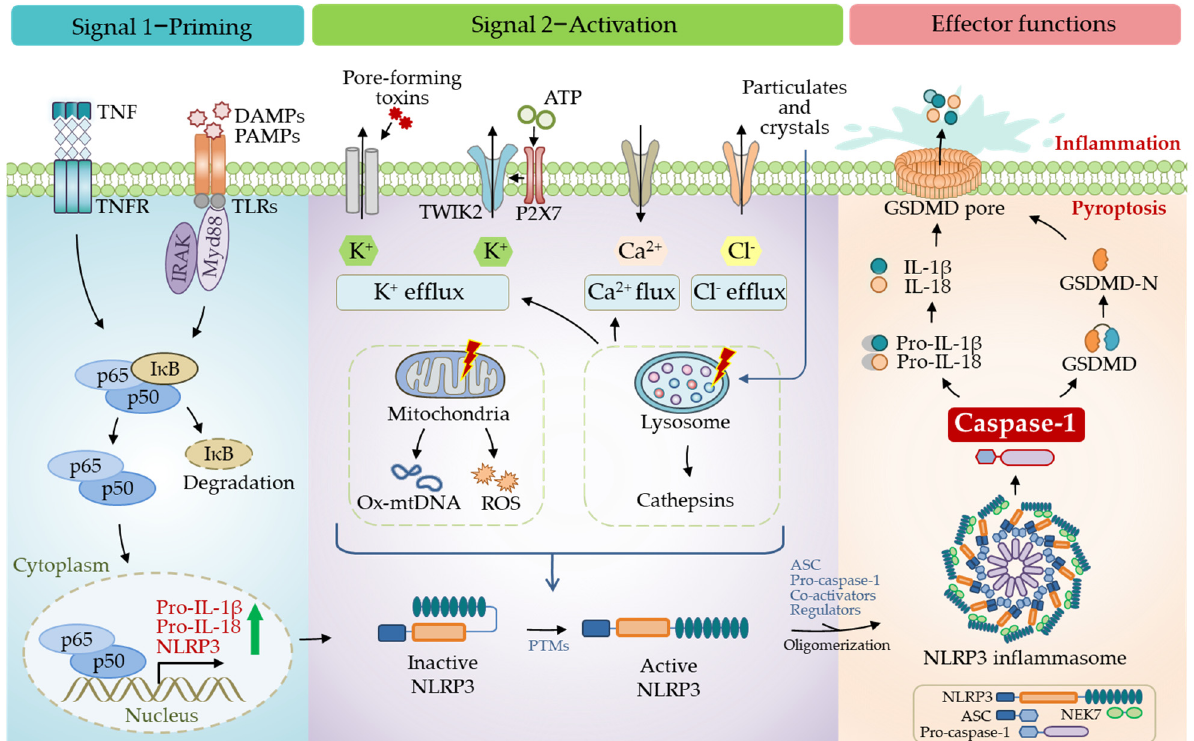
Figure 3. Activation of the NLRP3 inflammasome. Activation of the NLRP3 inflammasome undergoes two sequential steps. The priming process (signal 1) includes the recognition of PAMPs/DAMPs through TLRs and/or sensing of TNF α through TNFR, which induces the expression of NLRP3, pro-IL-1 β , and pro-IL-18 proteins via NF- κ B signaling. The activation process requires a signal (signal 2) that multiple pathogenic and sterile inflammatory cues can provide. Oligomerization and activation of NLRP3 inflammasome lead to the processing of pro-caspase-1 into the mature form, which in turn processes pro-IL-1 β , pro-IL-18, and GSDMD. The released N-terminal domain of GSDMD enters the membrane, forming a pore structure for releasing matured IL-1 β and IL-18 into the extracellular space, inducing pyroptosis and causing inflammation.